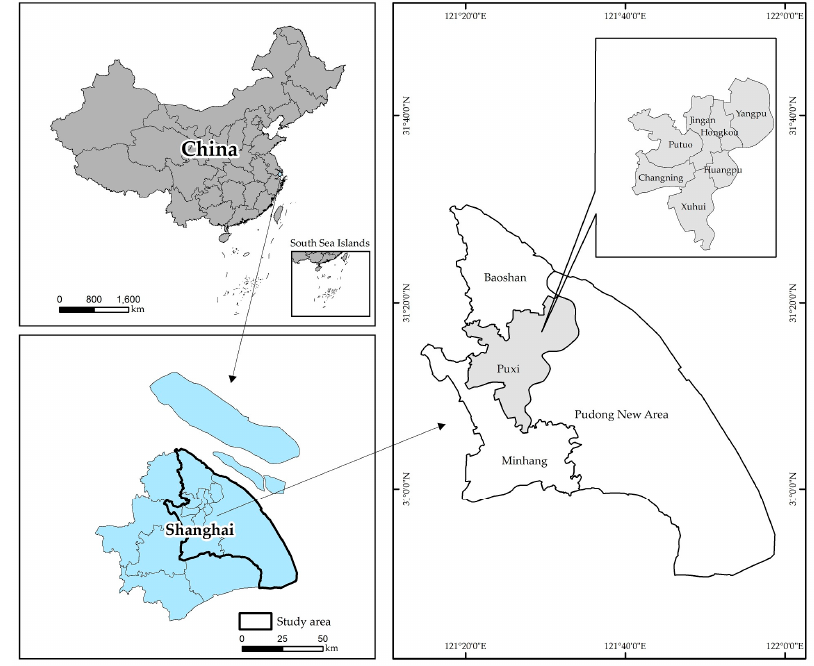
Figure 1. Map of Shanghai, China. Table 1. Example of Weibo